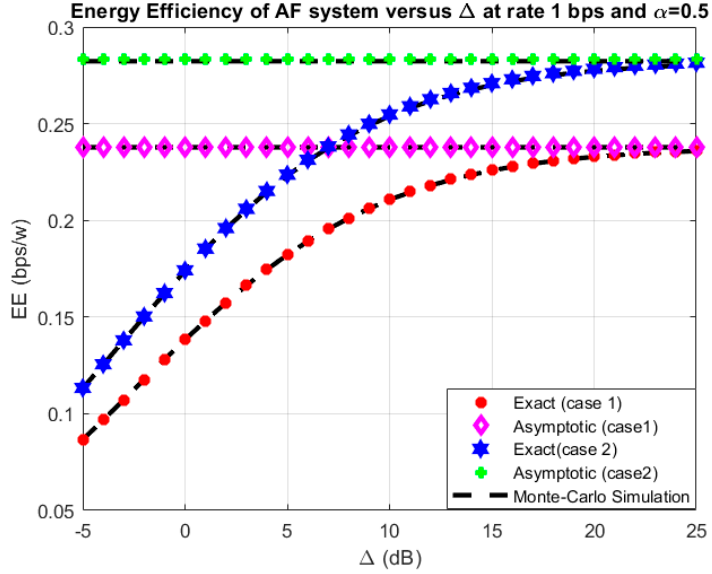
Energies 2019 , 12 , x FOR PEER REVIEW Figure 9. EE versus circuit power consumption (CPC). Figure 9. EE versus circuit power consumption (CPC).